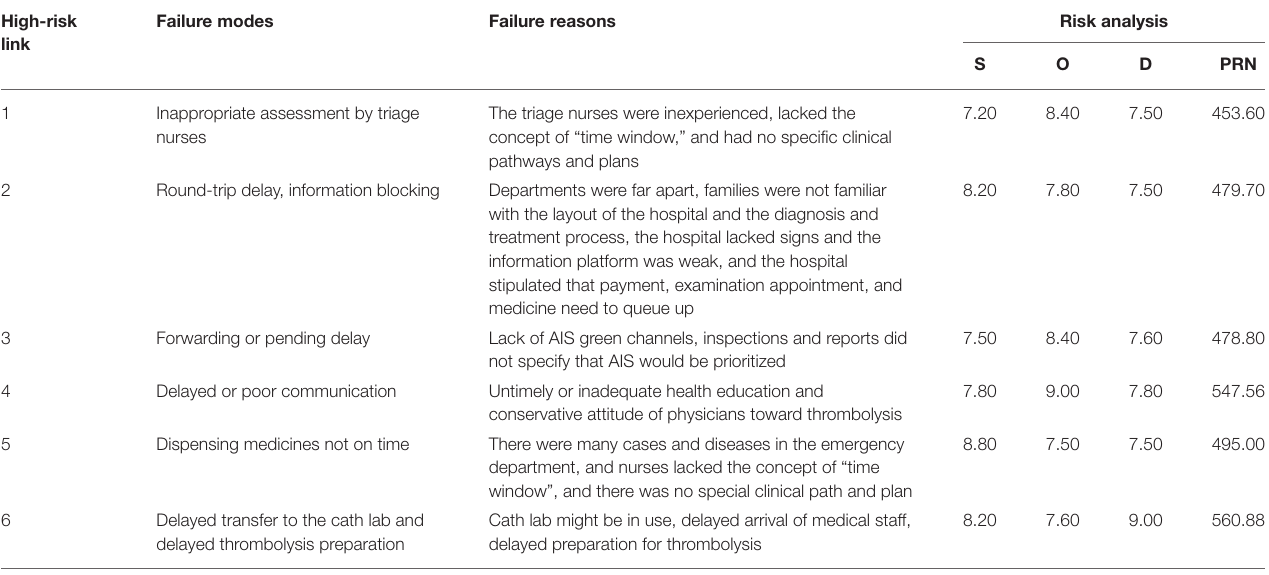
TABLE 2 | FMEA for emergency care of AIS patients.